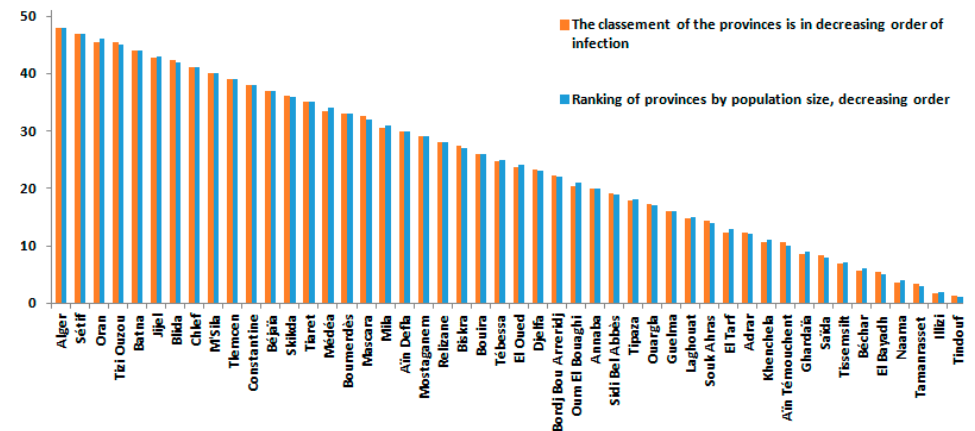
Figure 14. Classification of infection rates in Algerian provinces (48 provinces) by COVID-19 between 1 January 2021 and 15 August 2021.